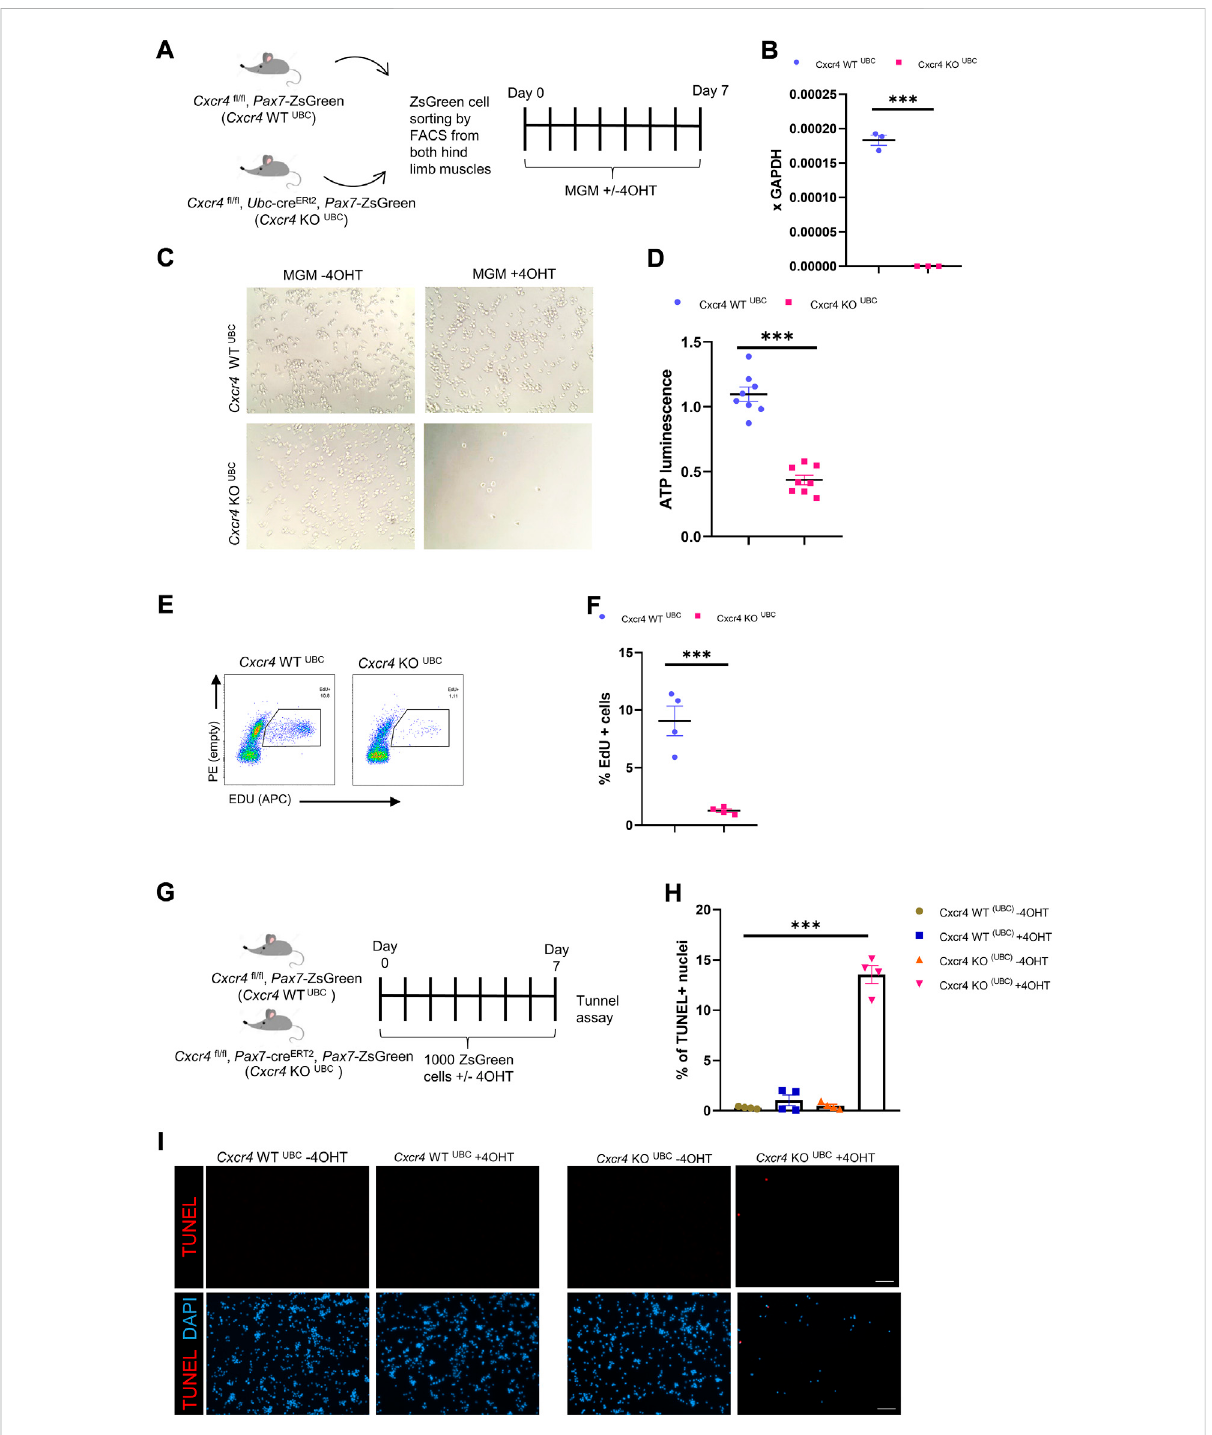
FIGURE 4 CXCR4 regulates early proliferation of satellite cells. (A) Schematic for Tamoxifen treatment and time of analysis. (B) RTqPCR for expression of Cxcr4 in myoblasts from Cxcr4 FL/FL ; Ubc-creERT2; Pax7-ZsGreen mice (KO UBC ) ( n = 3) or Cxcr4 FL/FL ; Ubc-creERT2; Pax7-ZsGreen controls lacking cre (WT UBC ) ( n = 3), treated with 4OHT. (C) Representative bright fi eld images for myoblasts from Cxcr4-KO UBC or WT UBC +/- 4OHT. (D) Cell growth assay measuring ATP luminescence in myoblasts from Cxcr4-KO UBC ( n = 3) or WT UBC ( n = 3) +/- 4OHT. Results are normalized to untreated. (E) Representative FACS plots for EdU staining of myoblasts 7 days in culture from Cxcr4-WT UBC +4OHT ( n = 3) and Cxcr4 KO UBC +4OHT ( n = 3). (F) FrequencyofEdU+cellsforreplicatesofthecellsshowninE. (G) Schematicfortheinvitroanalysisofapoptosis. (H) FrequencyofTUNEL+nucleiin Cxcr4-WT UBC and KO UBC cultured satellite cells ± 4OHT. (I) Representative immuno fl uorescence staining for TUNEL in Cxcr4-WT UBC and Cxcr4- KO UBC +/- 4OHT scale bar = 100 µm. Note also the low cell number in KO UBC + 4OHT. Data presented as mean ± SEM, ***p < 0.001 by t-test and two-way